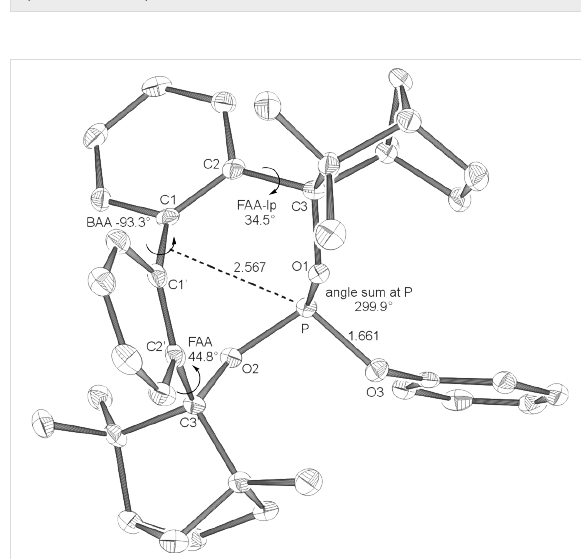
Figure 5: X-ray structures of BIFOP(O)-H ( 8 ). Distances are given in Å. (BAA = biaryl angle between C 2 -C 1 -C 1 '-C 2 '; FAA-lp = fenchyl-aryl dihedral angle between C 1 -C 2 -C 3 -O 1 ; FAA = fenchyl-aryl dihedral angle between C 1 '-C 2 '-C 3 '-O 2 ). The probability of ellipsoids is 40% (CCDC 270537).